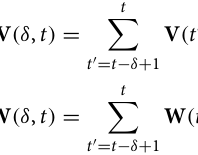
[Table S2:CPC detailed descriptions]—for 48 countries between 1995 and 2019; and on product exports—clas- sified according to the Harmonized System and whose number depends on the level of aggregation considered: 97 in the 2-digit case, 5053 in the 6-digit one—measured in US dollars for 169 countries between 2007 and 2017. As explained more in detail in the next section, our methodology requires selecting the countries in common between the two data collections, which turn out to be 47. All data can be represented as matrices: we denote by W ( t ) and V ( t ) the matrices corresponding respectively to the data on green patents and exported products in year t . Each matrix has a number of rows and columns equal to the number of countries c and activities a respectively, where the latter refer to either green technologies τ and exported products π . A more comprehen- sive description of the two datasets we use, including also a list of all countries at our disposal, is reported in the Supplementary Information [Data features]. Data preprocessing. Temporal aggregation. The information on both exported products and the patent- ed inventions is collected yearly; it is then possible to investigate the connections at different time scales. While annual data can offer more detailed results, i.e. distinct for each year considered, it may also supply them with more noise. In fact, data can fluctuate significantly from one year to another. In order to minimize the possibility that the detected green technology-product connections are the result of data fluctuations, we consider the